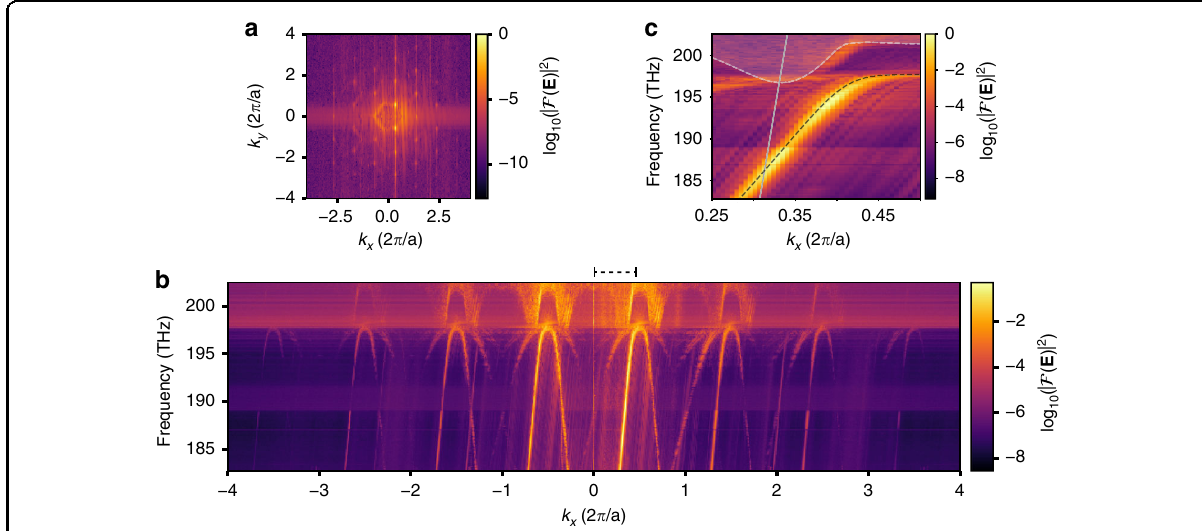
Fig. 2 Momentum space of the VPC edge state. a Two-dimensional Fourier transform of the real-space amplitude distribution of the PhC mode. High-intensity points are periodically separated by the reciprocal lattice vector 2 π / a in the direction of propagation k x along the edge and by 4 π / √ 3 a in the transverse direction k y , representing the bulk reciprocal symmetry. b Experimentally retrieved dispersion diagram. Bright lines of positive slope indicate positive group velocity (forward-propagating modes), while lines with negative slope indicate a negative group velocity (backward- propagating modes). Consecutive Bloch harmonics are separated by the size of a single Brillouin zone (2 π / a ). Frequencies above 197.5 THz correspond to bulk bands. The Fourier intensity for each excitation frequency is normalized to the overall maximum value. In addition to the dominant modes in the forward and backward directions, lines with half and a third of the dispersion slope appear. These are attributed to a nonlinear interaction with the scanning near- fi eld probe (see Supplementary Sec. III). c A close-up of the experimentally retrieved dispersion diagram limited to the fi rst Brillouin zone is denoted by black dashed brackets in b . The black dashed lines indicate the numerically simulated values for the edge state (see Methods for details). The solid gray line denotes the light line and the gray dashed lines with grayed-out regions indicate the onset of the bulk